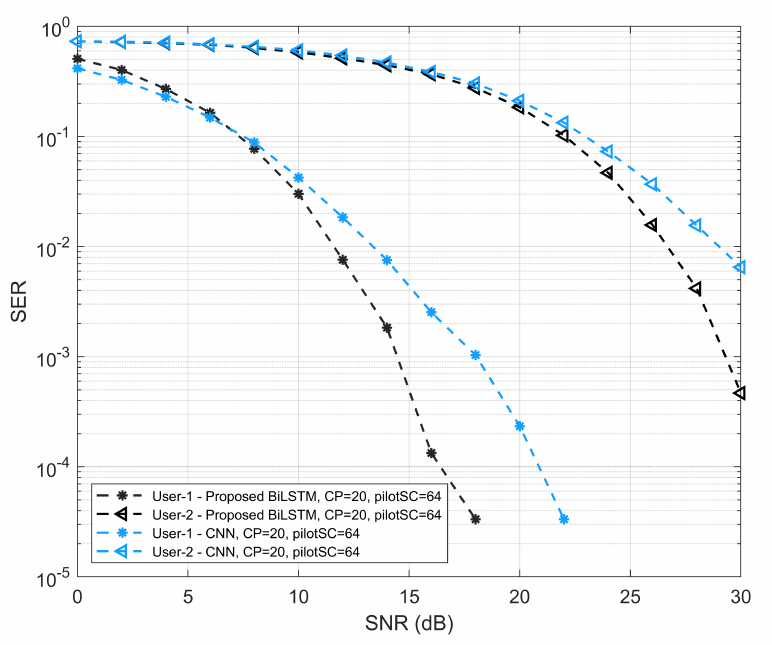
Figure 7. SER versus SNR performance of proposed Bi-LSTM model and CNN